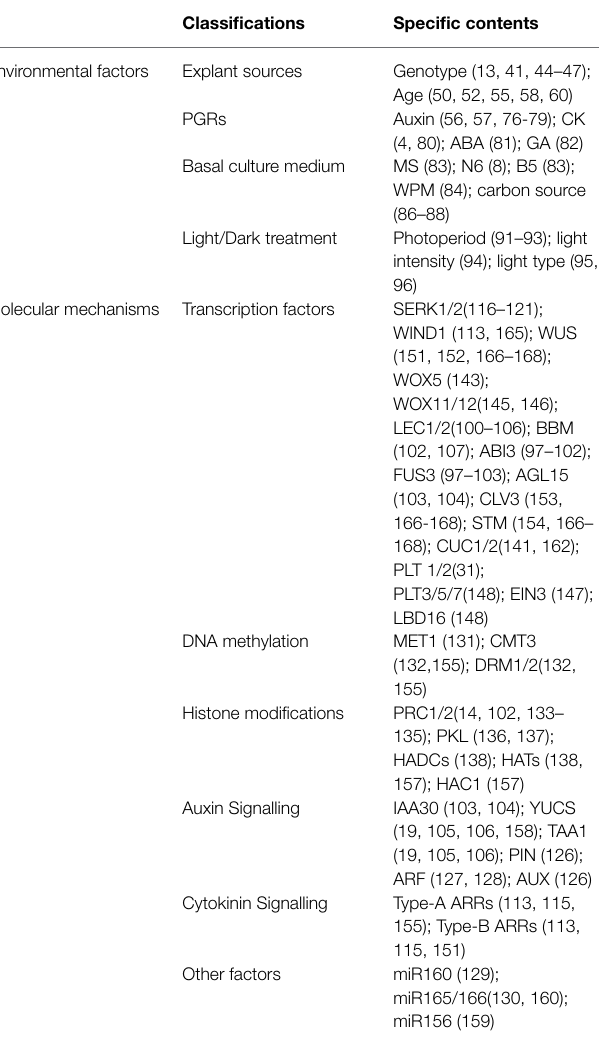
TABLE 1 | Environmental factors and molecular mechanisms affecting plant regeneration in tissue